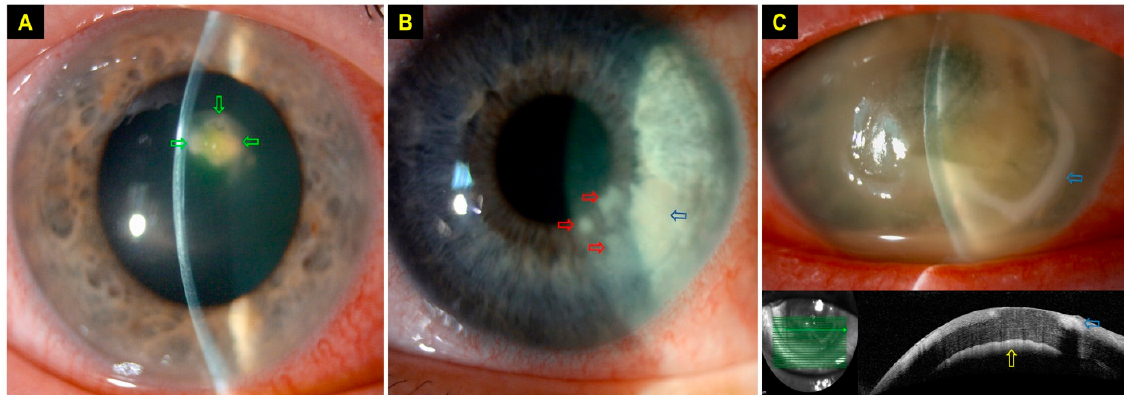
Figure 1. Slit-lamp photography demonstrating typical signs of fungal keratitis (FK). ( A ) A small contact lens (CL)-related FK with multifocal infiltrates (green arrows) with feathery borders. ( B ) A CL-related FK with multifocal infiltrates of feathery borders, with an area of main infiltrate (blue arrow) and three satellites lesions (red arrows). ( C ) A case of severe FK with hypopyon, ring infiltrate (blue arrows) and endothelial plaque (yellow arrow).